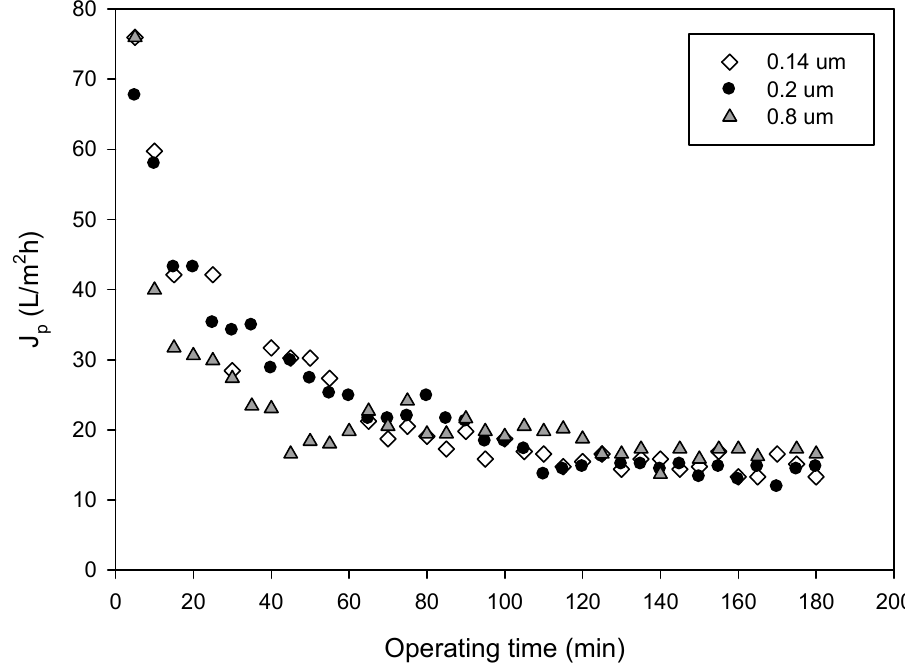
Figure 4. Time course of permeate flux for the investigated membranes. Operating conditions: TMP, 2.25 bar; Q f , 4.93 L/min; T, 25 °C. Table 3. Fitted parameters for fouling models according to the modified Hermia’s models for cross- flow filtration, unified model of flux decline, and statistical model analysis for the studied membranes. S-W: Shapiro–Wilks test; K-S: Kolmogorov–Smirnov test; RMSE: root mean square error.